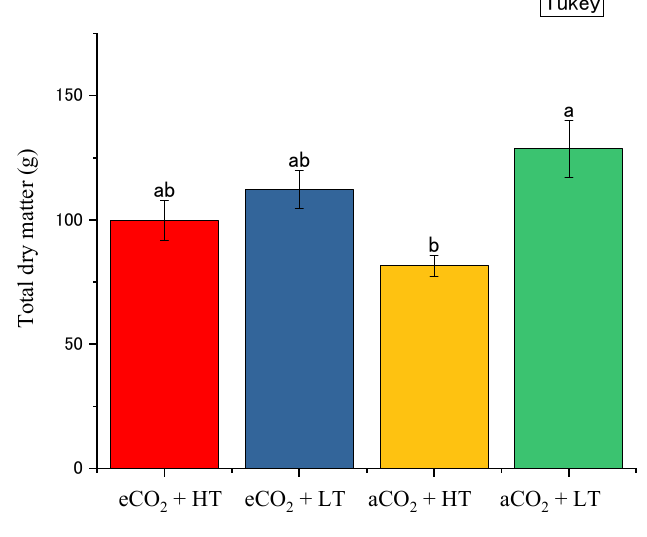
Figure 4. Total and leaf dry matter at 14, 28, and 43 d after transplantation under aCO 2 + LT, aCO 2 + HT, eCO 2 + LT, and eCO 2 + HT treatments. Vertical bars represent SE of mean ( n = 10). Error bars indicate SE of mean. Different lowercase letters indicate significant differences among treatments ( p < 0.005)